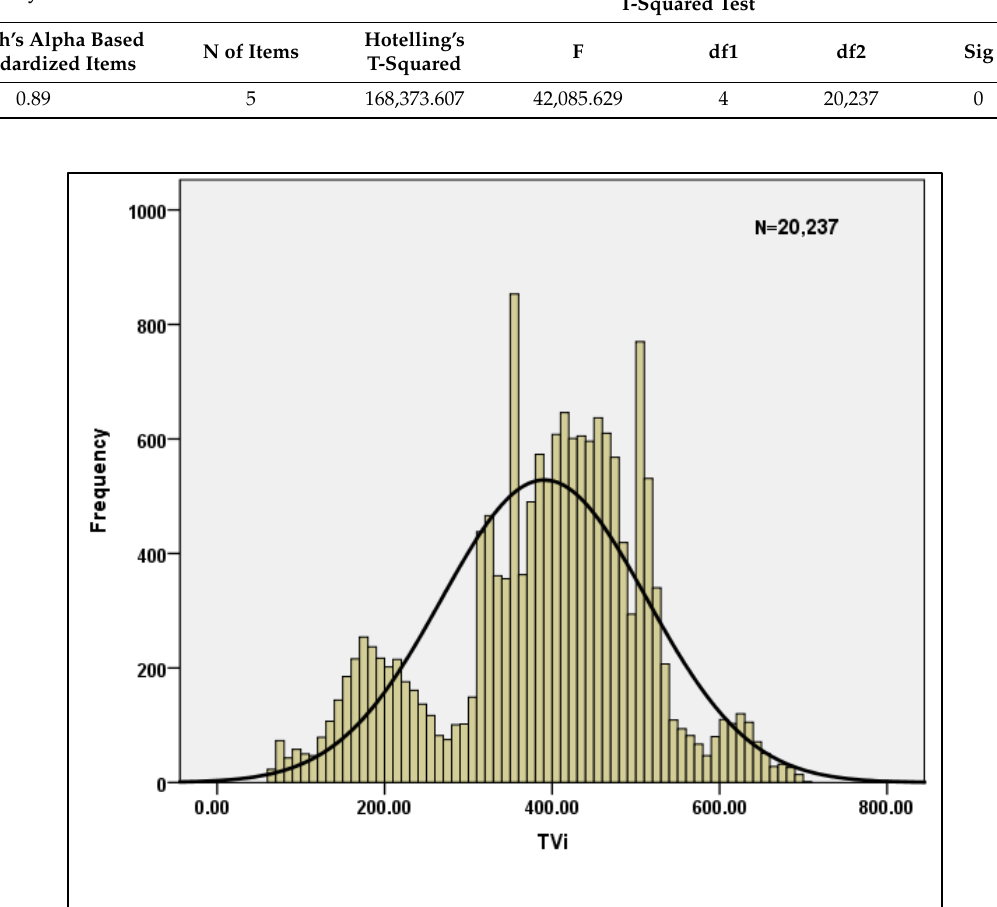
Figure 4. Normality plot for TVi.